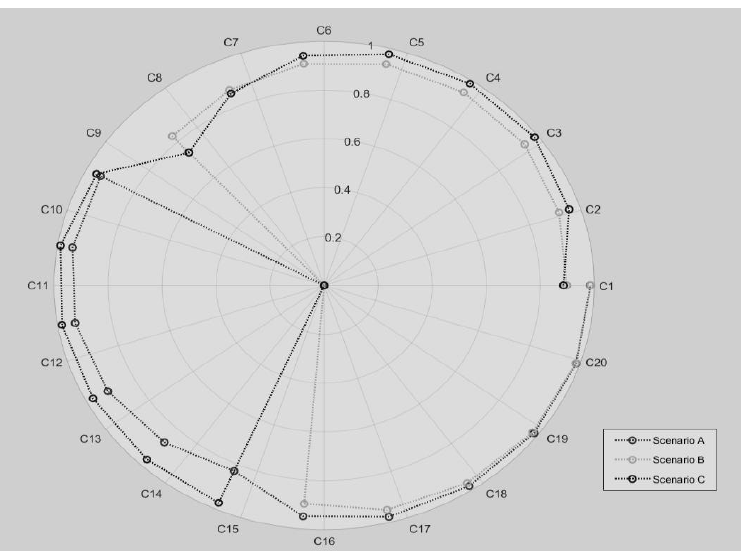
Fig. 5. Scenario chart and scenario